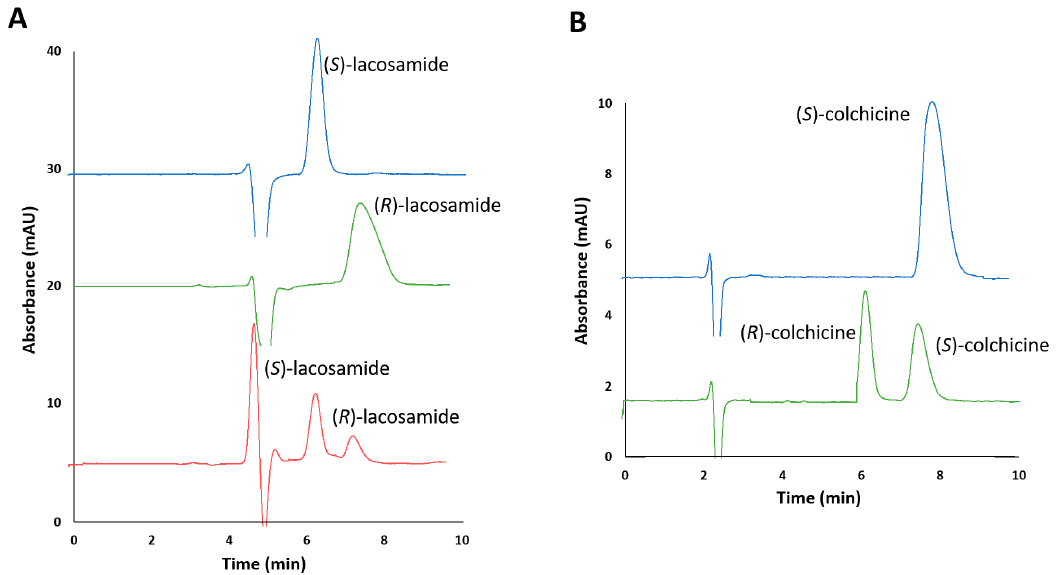
Figure 3. ( A ) Chromatograms corresponding to ( S )-lacosamide pure enantiomer standard solution (1000 µg/mL), ( R )-lacosamide pure enantiomer standard solution (1000 µg/mL) and racemic standard solution containing 250 and 50 µg/mL of ( S )-lacosamide and ( R )-lacosamide, respectively. ( B ) Chromatograms corresponding to ( S )-colchicine pure enantiomer standard solution (500 µg/mL) and racemic standard solution of colchicine containing 250 µg/mL of each enantiomer. Experimental conditions: mobile phase n -hexane/2-propanol (80/20, v/v ) with 0.2% of diethylamine, capillary flow rate 200 nL/min, λ : 210 nm (lacosamide) and 243 nm (colchicine), room temperature.